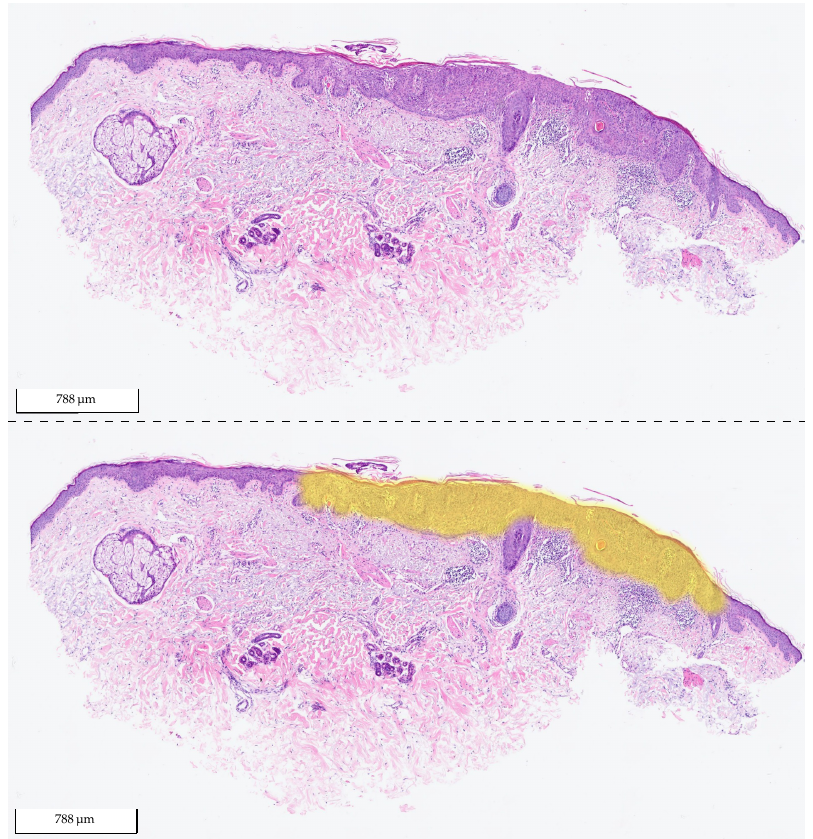
Figure 12. Exemplary tissue section of BD from the test set of Center 0 ( upper picture ) and the same tissue section with its corresponding 2 heat map overlays ( lower picture ): yellow (BD) and orange (SK). The probability value between 0 and 1 is used to set the transparency. As the model did not detect any SK in the section, there is no visible orange (fully transparent). The section was correctly classified by the algorithm as BD.